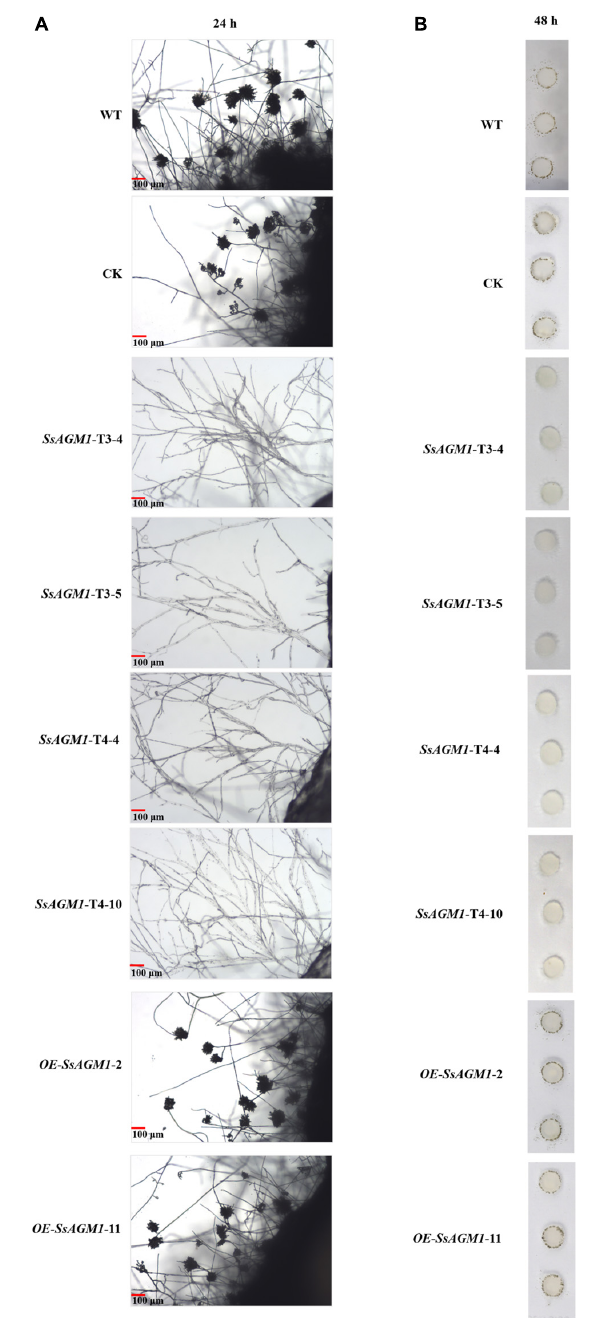
FIGURE 7 | SsAGM1 is indispensable for the formation of infection cushions in Sclerotinia sclerotiorum. (A) Micro observation of mycelial morphology on a glass slide at 24 h after inoculation. (B) Infection cushions were observed on glass slides that surrounded mycelia-colonized agar plugs at 48 h after